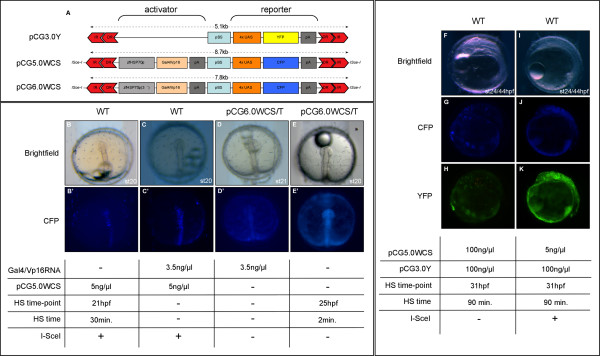
Schematic representation of Gal4/Vp16-UAS expression vectors (A), comparison of induction levels between transient and transgenic approaches (B-E') and transient Gal4/Vp16 mediated reporter expression in medaka embryos induced by heat-shock (F-K). A; Gal4/Vp16 activator units driven by a 1.5 kb (pCG5.0WCS) or a 600 bp (pCG6.0WCS) heat-shock promoter fragment followed by a SV40 polyadenylation signal are shown on the left. Reporter units are separated from the activator units by the pBSII backbone. YFP (pCG3.0Y) or CFP (pCG5.0WCS/6.0WCS) open reading frames are placed downstream of 4 UAS elements and followed by a SV40 polyadenylation signal. Entire expression cassettes are flanked by the IR/DRs of the SB transposon system. Additionally, I-SceI meganuclease sites flank the expression cassettes of activator vectors. Abbreviations and actual sizes of each vector are given. B-E'; Wild type medaka embryos were injected with pCG5.0WCS and MN and subjected to heat-shock treatment (B, B') or with MN and Gal4/Vp16 mRNA without treatment (C, C'). Similarly, the transgenic activator line pCG6.0WCS/T was injected with Gal4/Vp16 mRNA (D, D') or subjected to heat-shock treatment (E, E'). Anterior is to the top (B-E'). DNA and RNA concentrations are indicated together with the developmental stage and the duration of heat-shock treatment. Microinjection of the activator/reporter plasmid pCG5.0WCS results in activation of CFP according to the distribution of plasmid DNA (B-C'). In contrast, induction of activator and reporter in the transgenic line by mRNA injection or heat-shock treatment results in ubiquitous and entirely uniform expression of CFP (D-E'). F-K: Activator and reporter vectors were injected into one-cell stage medaka embryos. Anterior is to the left (F-K). Developmental stage at heat-shock induction and duration of treatment is indicated. HS treatment of up to 2 hours did not interfere with embryonic development but yielded detectable transgene expression (F-K). CFP (internal reporter) shows the expression pattern of the activator Gal4/Vp16. YFP shows activation of the independent reporter. Co-injection of activator pCG5.0WCS and independent reporter pCG3.0Y (100 ng/μl each) resulted in mosaic activation of reporter gene expression (F-H) only. Co-injection of activator pCG5.0WCS (5 ng/μl) and independent reporter pCG3.0Y (100 ng/μl) with I-SceI resulted in a broad range of different levels of mosaicism. Notably, 16% of co-injected embryos showed highly uniform expression (I-K). Abbreviations: CFP, cyan fluorescent protein; HS, heat-shock; hpf, hours post fertilization; IR/DR, inverted/direct repeats; MN, meganuclease; pA, SV40 polyadenylation signal; pBS, pBluescriptII; st, developmental stage; UAS, upstream activating sequence; zf, zebrafish.